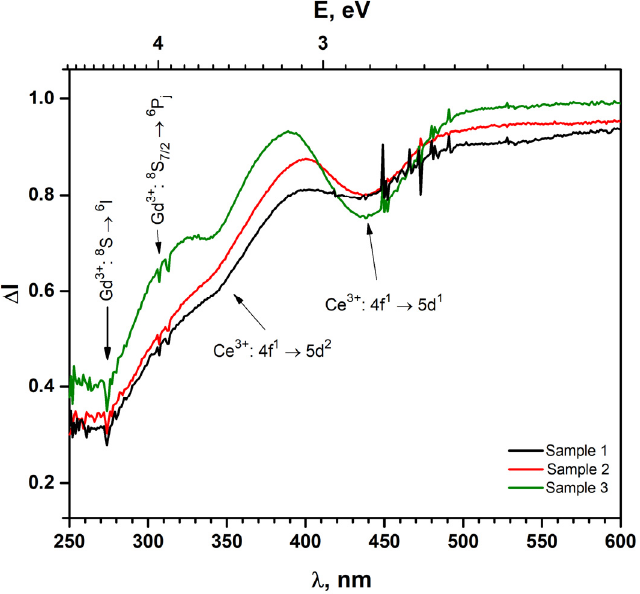
Figure 4. Diffuse reflection spectra of GAGG:Ce,Cr,Mg,Ca powder